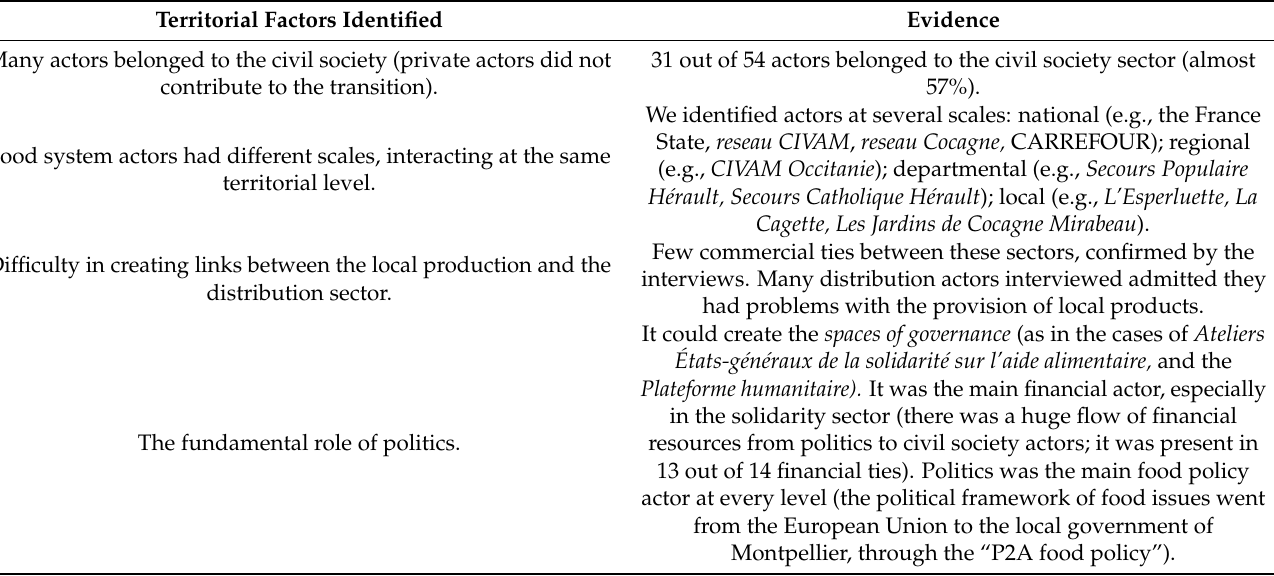
Table 4. The results summarized: territorial factors and related evidence. Territorial Factors